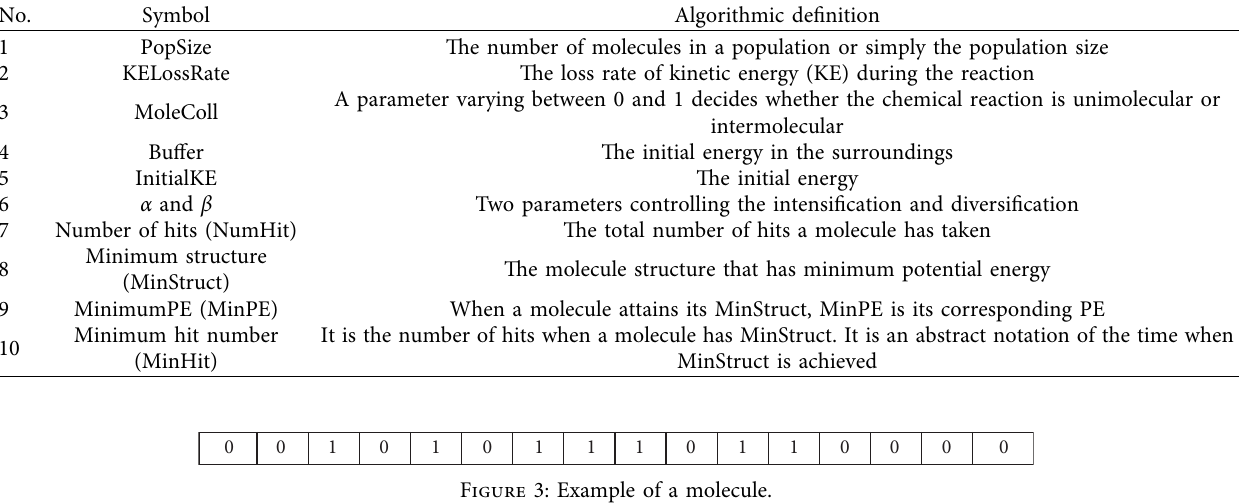
Figure 3: Example of a molecule.